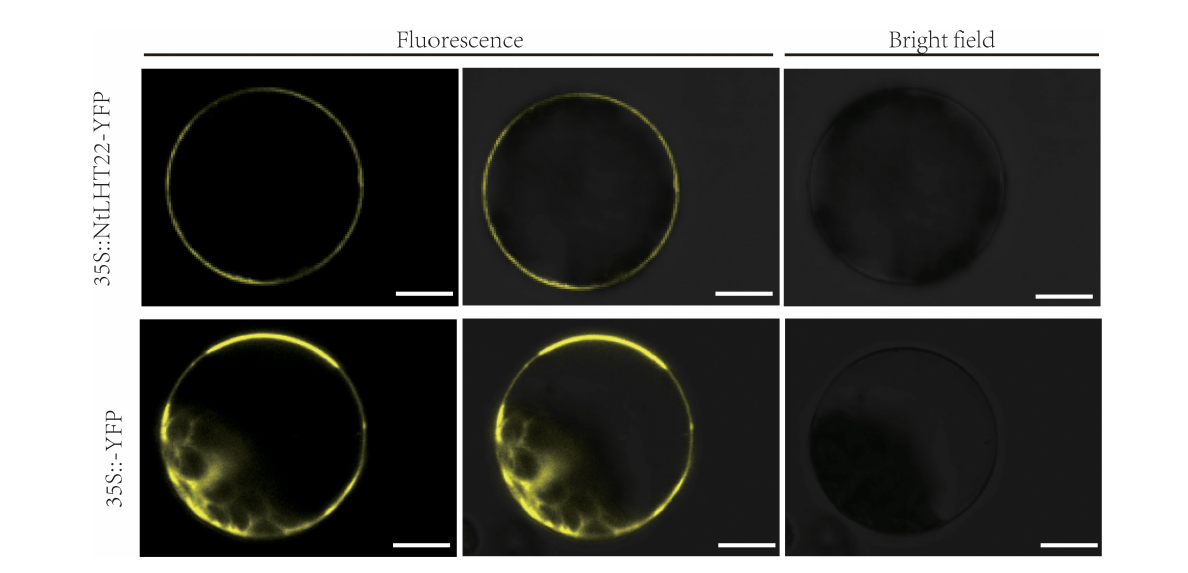
FIGURE8 Subcellular localization of NtLHT22 proteins. The coding sequence (CDS) of NtLHT22 was inserted into pEarlyGate101 vector and transiently expressed in tobacco protoplasts. Bar = 10 µ